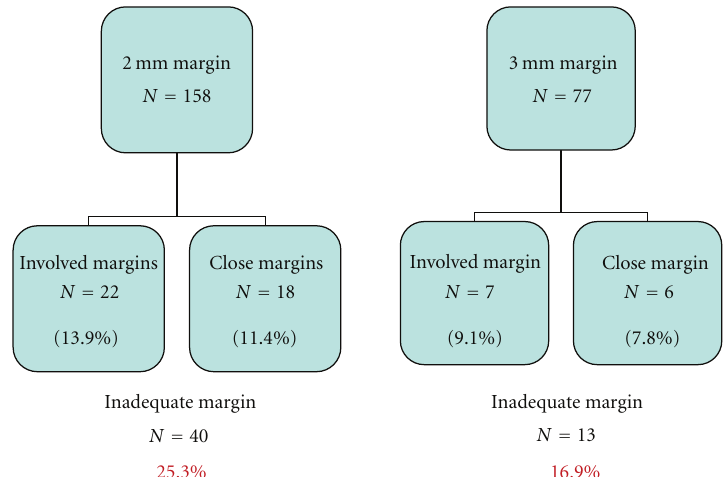
Figure 4: Treatment outcome—the greater the skin margin taken on tumour excision, the better the tumour clearance rate.